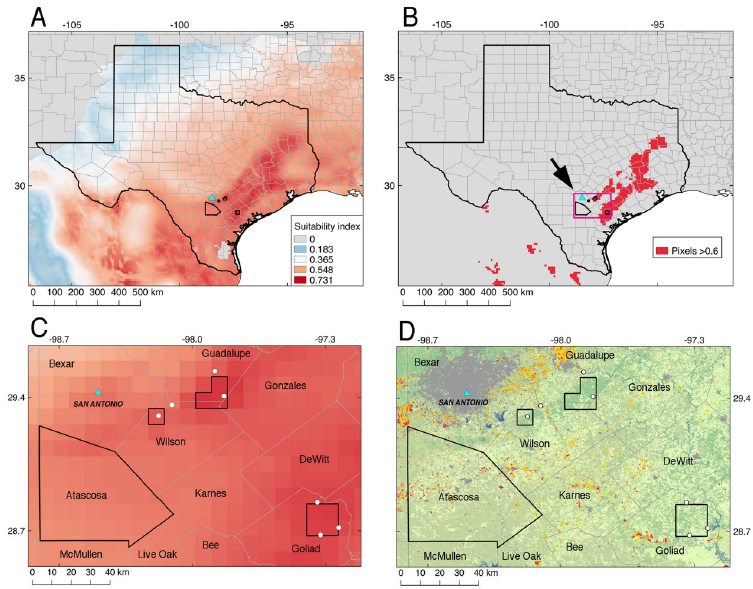
Fig 1. Ecological niche modeling for B . pseudomallei transferred to Texas to inform environmental sampling. For reference, the light blue triangle represents San Antonio, Texas and the polygon south of San Antonio represents Atascosa County, where two locally acquired human melioidosis cases were reported. (A) Selected continuous output of the ecological niche model. (B) Binary map showing highly suitable pixels in red, defined as those with a suitability index above 0.6. (C) Zoom-in to the inset on panel B showing the pixels (polygons other than the one representing Atascosa County) with the highest suitable values that are the most proximal to Atascosa County selected for environmental sampling (white circles = actual individual sampling sites). (D) Same as panel C using the Cropland Data Layer from the NASS CropScape geospatial portal from the USDA National Agricultural Statistics, representing the 2019 product with a resolution of 30 m (Available through: https://nrcs.app.box.com/v/gateway/folder/ 22218925171; [33]). Most representative land cover classes include: gray = developed, orange = sorghum plantations, red = cotton plantations, light green = mixed and deciduous forest, pale leaf =